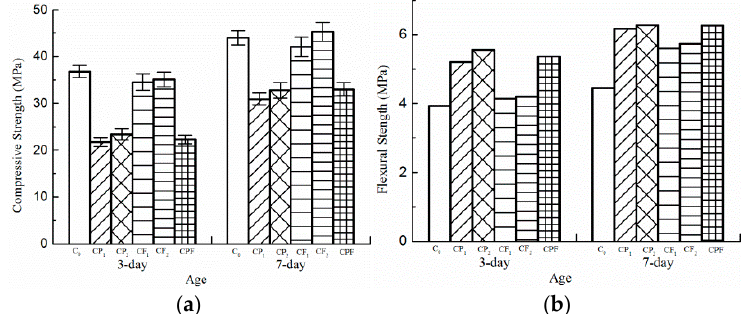
Figure 6. Strength test results. ( a ) Compressive strength; ( b ) Flexural